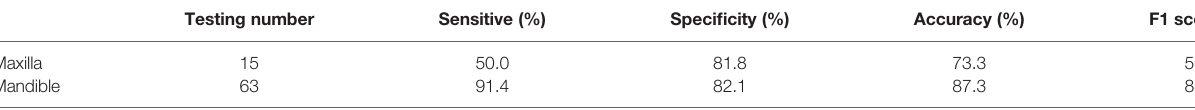
TABLE 3 | Diagnostic accuracy in the maxilla and mandible.